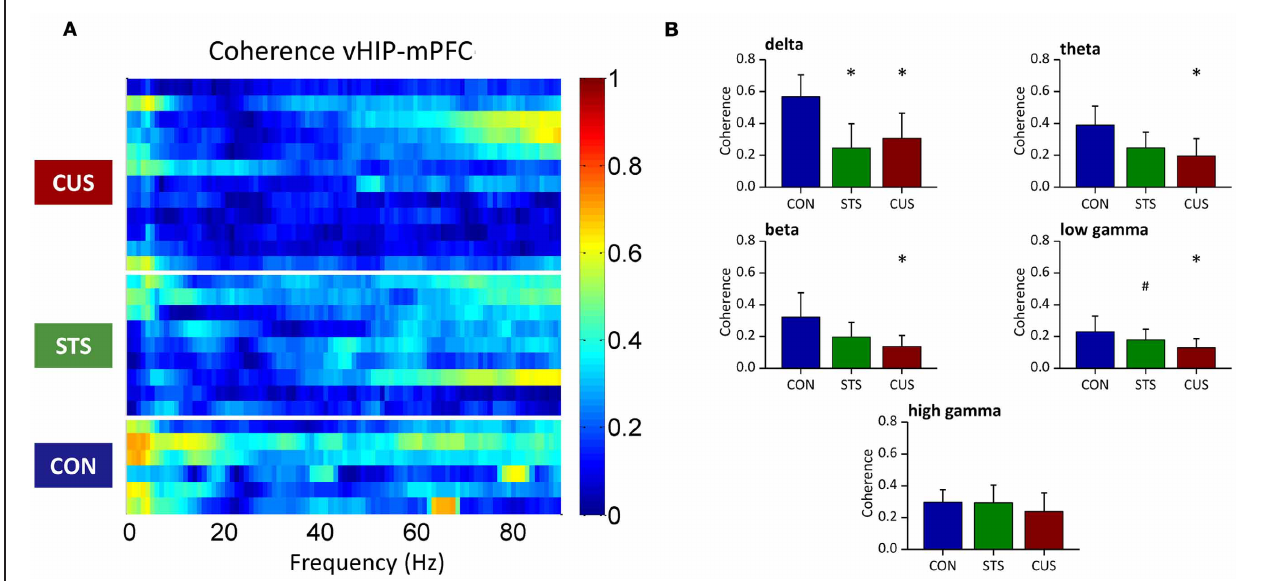
comparison of the coherence values between mPFC and vHIP for delta (1–4Hz), theta (4–12Hz), beta (12–20Hz), low gamma (20–40Hz), and high gamma (40–90Hz) frequency bands. ∗ Statistically different from CON, p < 0 . 05; # Statistically different from CUS, p < 0 . 05; error bars represent